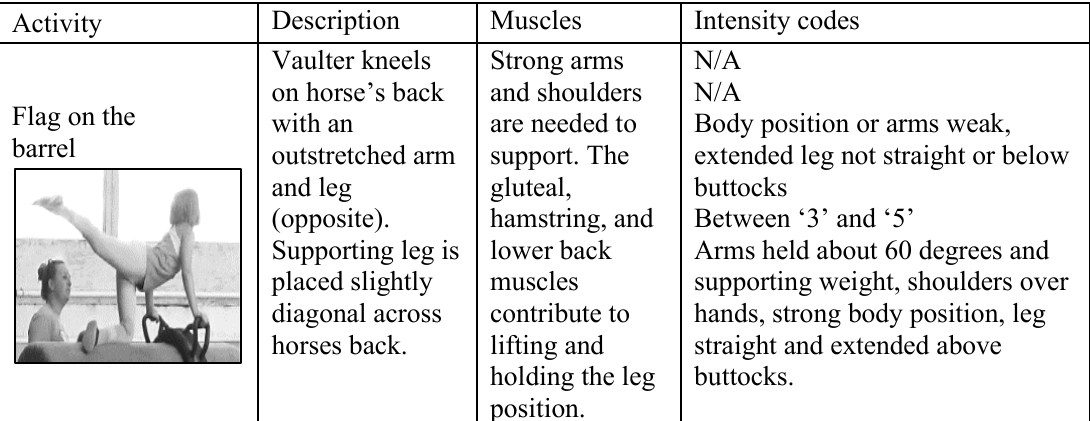
Table 1. An example of how a barrel vaulting activity was coded for strength engagement.